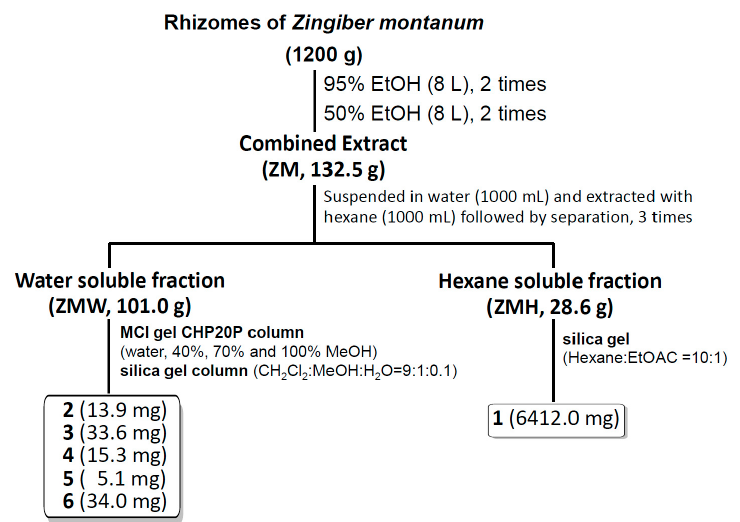
Figure 1. Schematic flowchart of extraction and isolation of compounds from the rhizomes of Zingiber montanum .